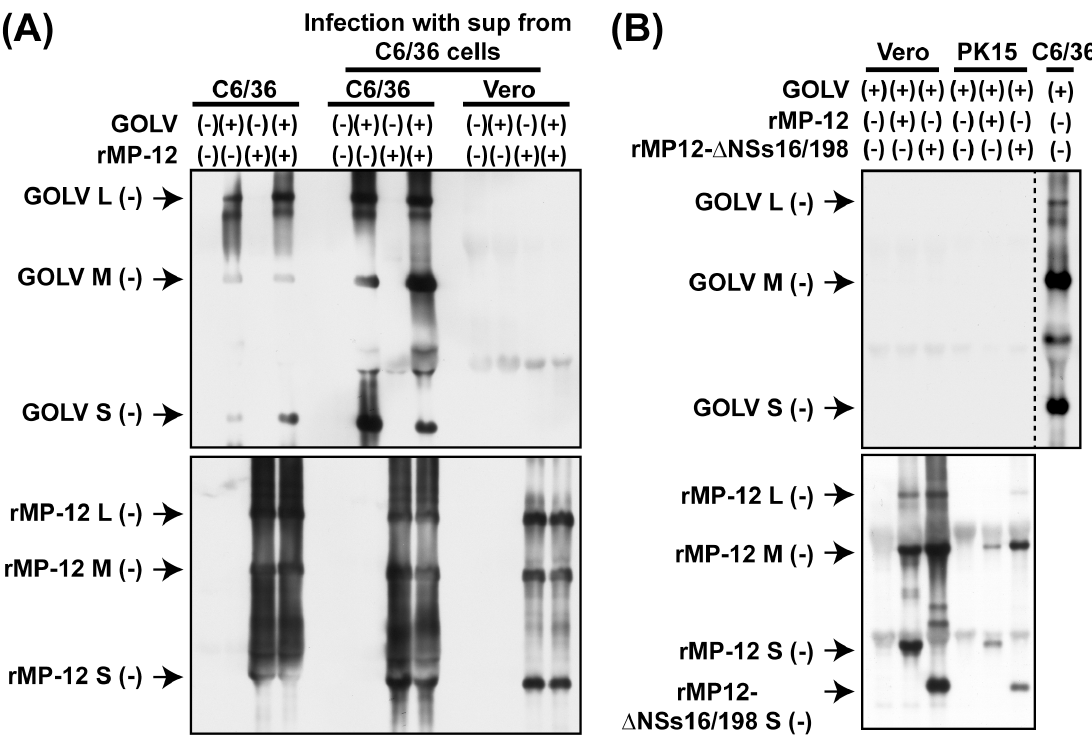
Fig 2. Co-infection of Gouleako goukovirus (GOLV) and RVFV. (A) C6/36 cells were mock-infectedor infected with GOLV (8 MOI) and/or rMP-12 (0.5 MOI) at 28˚C. Total RNA was extracted at 72 hpi (left four lanes). Culture supernatants were collectedand transferred into either C6/36 cells (middle four lanes)or Vero cells (right four lanes). Total RNA was then extracted at 72 hpi. The presenceof L-, M-, and S-segment RNA of GOLV (top panel)or RVFV (bottom panel)was analyzedby Northern blot. (B) Vero or PK15 cells were infected with GOLV (8 MOI) with or without either rMP-12 (0.5 MOI) or rMP12- Δ NSs16/198 (2.0 MOI) at 28˚C. Total RNA was extracted at 18 hpi, and the accumulation of viral RNA was analyzedby Northernblot. Top panel:probes to detect negative-sense GOLV L-, M-, and S-segments, Bottom panel:probes to detect negative-sense RVFV L-, M-, and S-segments. GOLV RNA derived from C6/36 cells infected with GOLV (8 MOI) was used for the positive control for GOLV probeson the